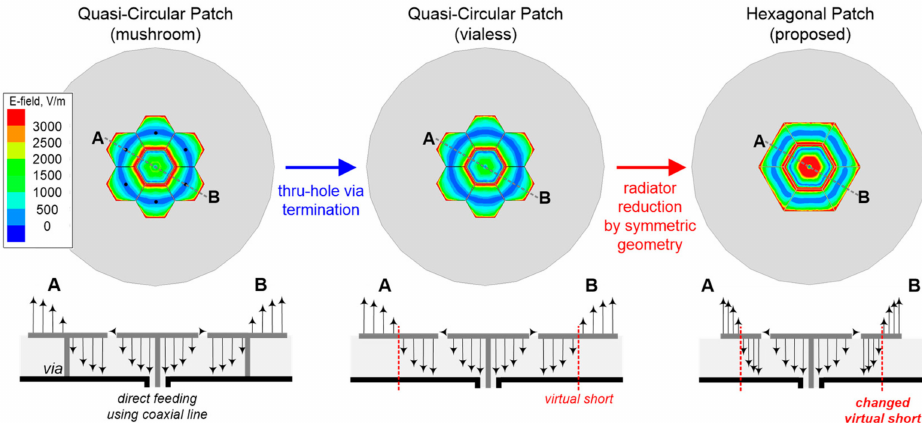
Figure 2. Concept with simulated electric field distributions for the TM 02 mode and their electric field vector magnitudes in a cut-plane of